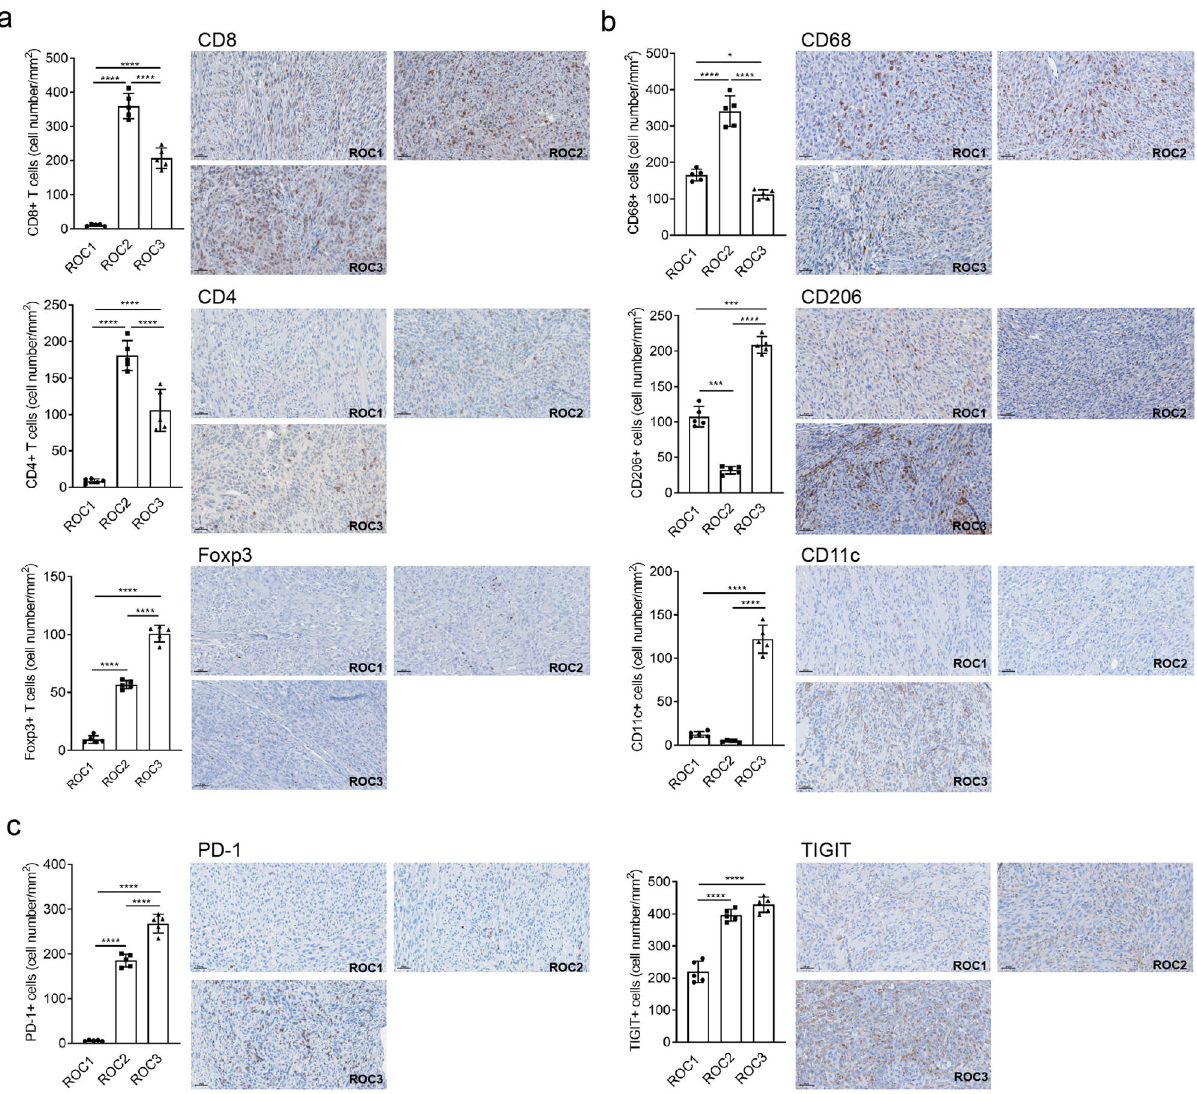
Fig. 2 ROC1 – 3 TIMEs have distinct patterns of immune in fi ltration and exclusion. IHC quanti fi cation analysis shows that T-lymphocyte markers ( a ), macrophage markers ( b ), and immune checkpoints ( c ) are differentially expressed among ROC1 – 3 tumors. The images were scan using Vectra Polaris imaging system and images were process using Phenochart software (version 1.0.12). Representative antibody-stained images are shown and include scale bars 50 μ m (bar representative of n = 3 stained tumors, error bars = standard deviations). One-way ANOVA with Tukey ’ s post hoc test p -values shown, * p < 0.05, *** p < 0.005, **** p < 0.0001, for all com p arisons of the ROC tumors (error bars = standard